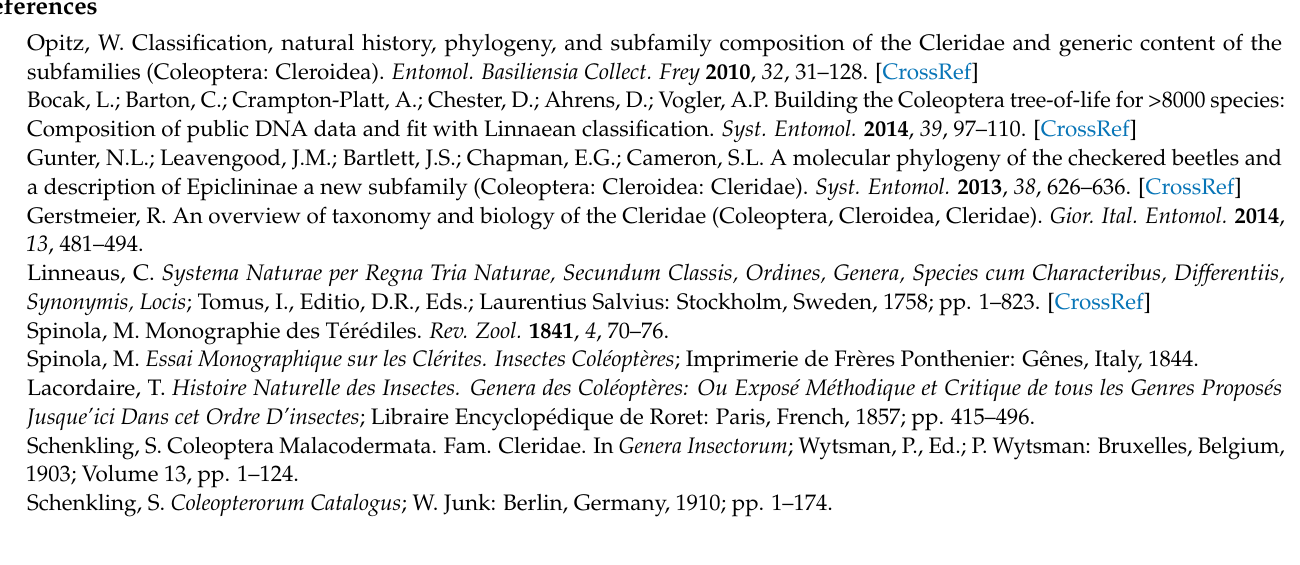
inferred from the BI and ML analyses of the PCGRNA (left), PCGrRNA (middle) and PCG (right) datasets. Numbers at the branches are bootstrap values (upper) or posterior probabilities (lower), Table S1: Best models calculated by BI of four mitochondrial datasets, Table S2: Best models calculated by IQ of four mitochondrial datasets, Table S3: The length and A+T% of different components of mitogenomes in Cleridae, Table S4: A+T% of each PCG of mitogenomes in Cleridae, Table S5: A+T% and A+T skew, C+G% and G+C skew in the 13 PCGs of mitogenomens in Cleridae, Table S6: Codon usage of PCGs of mitogenomes in Cleridae; Table S7: RSCU of the mitochondrial PCGs of Cleridae, Table S8: Amino acid constituents among four subfamilies of